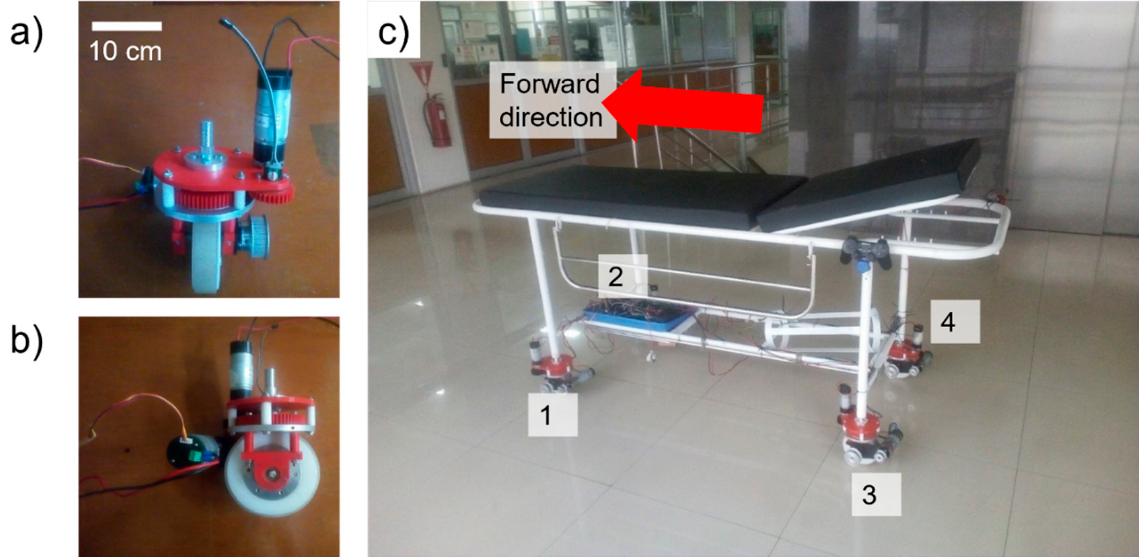
Figure 3. ( a ) Front view and ( b ) side view of fabricated prototype of the swerve drive module and ( c ) Prototype of the motorized hospital bed with numbered motors.